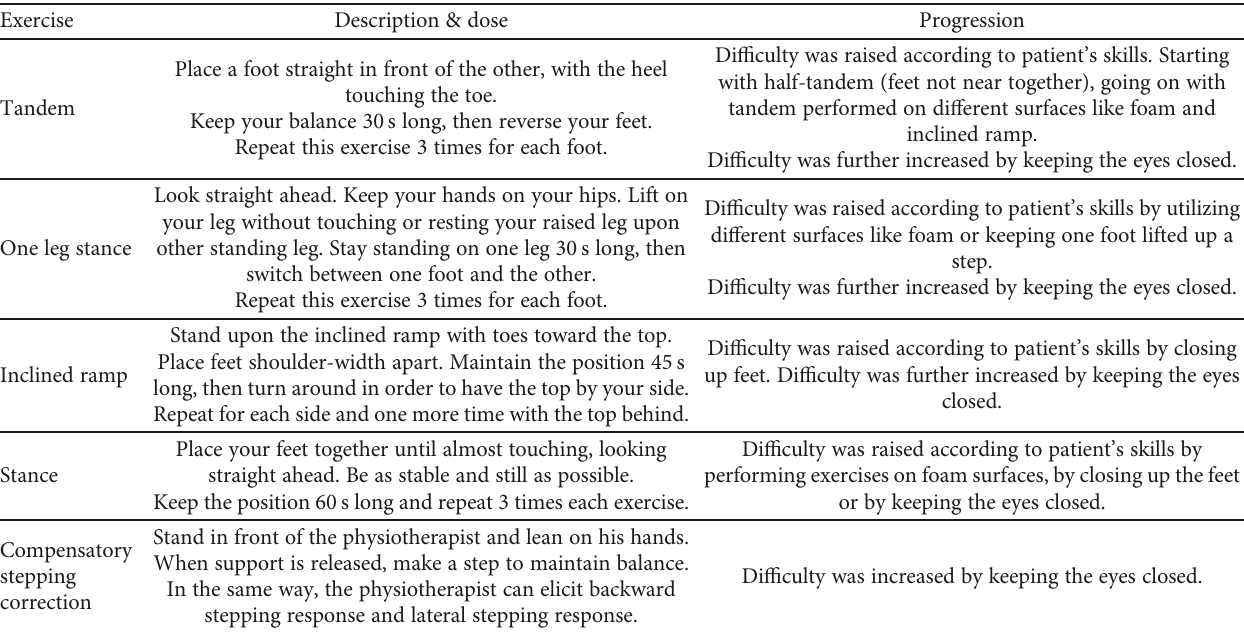
Table 2: Balance exercises administered to the PD-E group, based on the Otago Exercise Program [33] and guideline program for Parkinson ’ s disease [38, 39]. Exercise